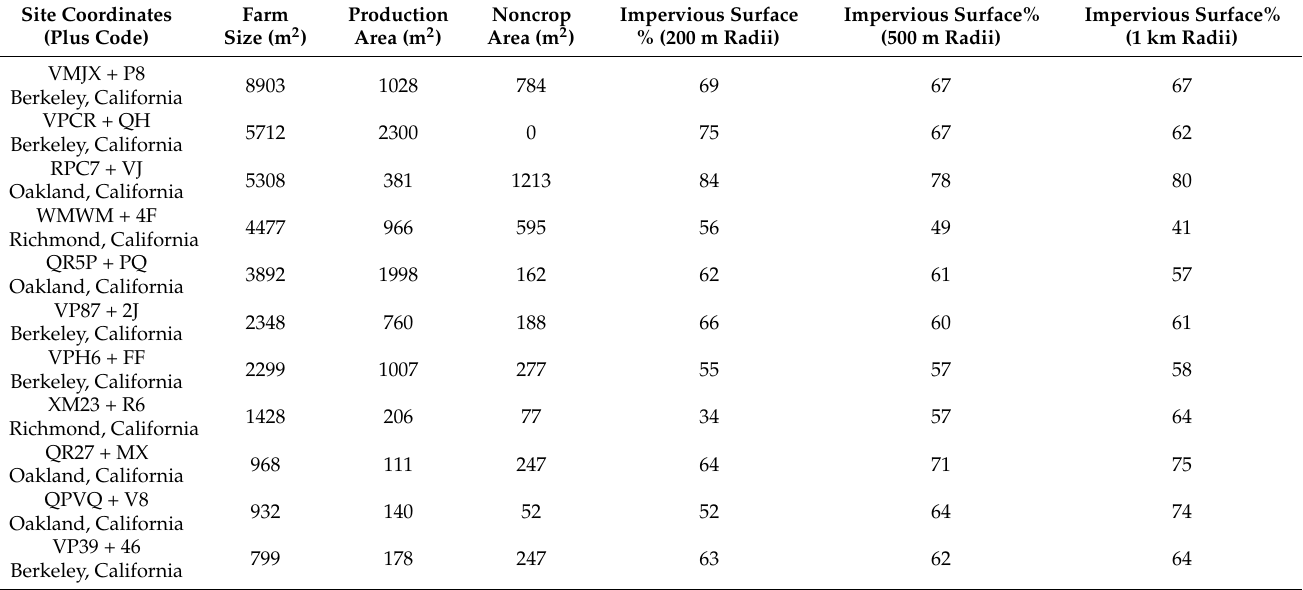
Table A1. Farm spatial characteristics and location.